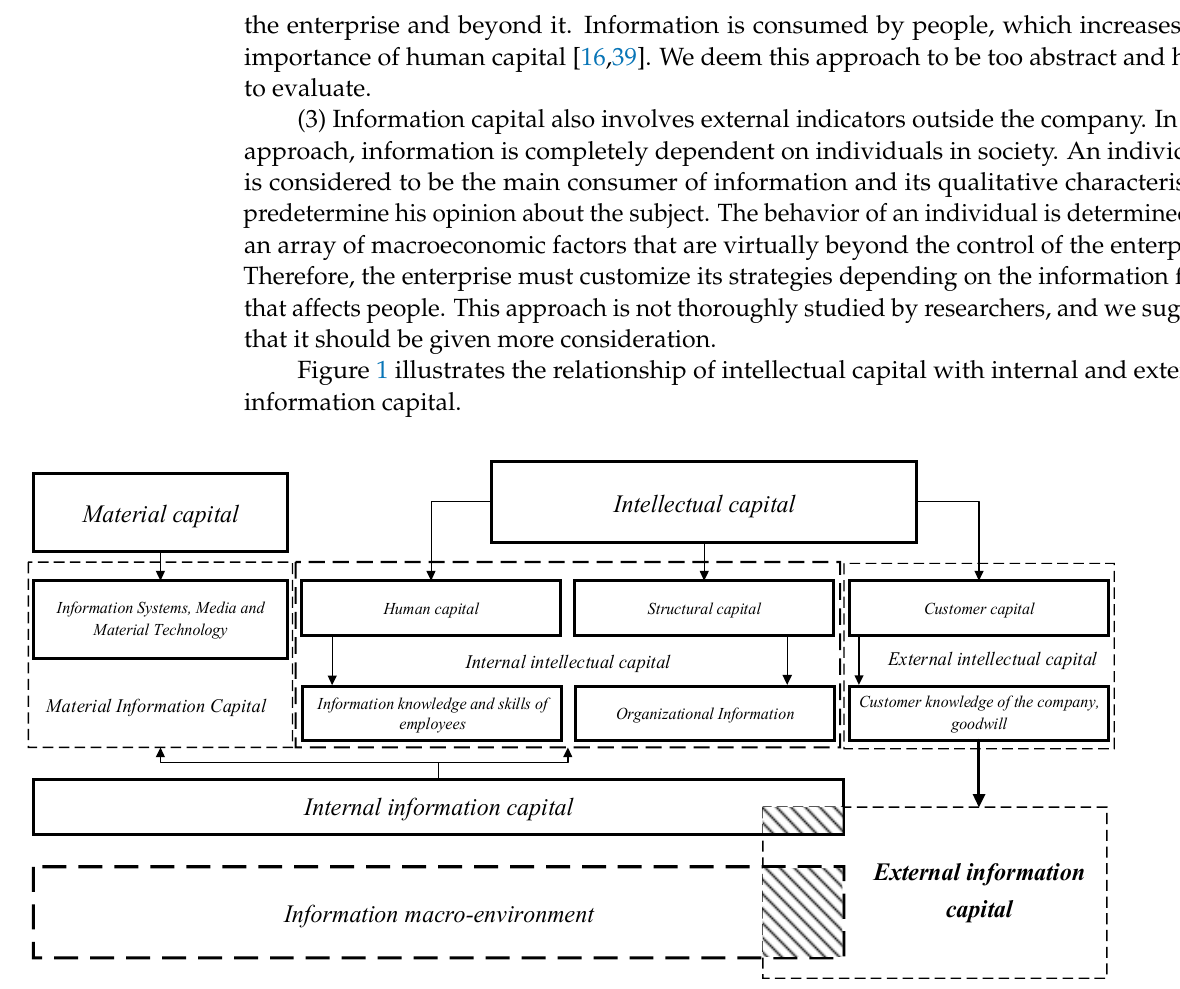
Figure 1. Information capital in the generalized structure of intellectual capital. Source: developed by the authors.